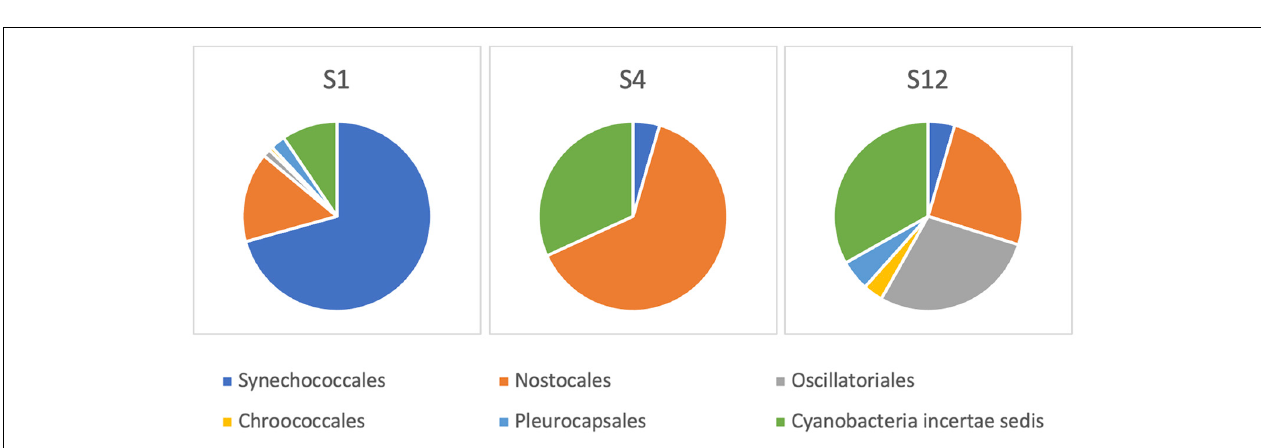
FIGURE 7 | Cyanobacterial community composition based on 16S rRNA next-generation sequencing at the Ural River S1, S4, and S12